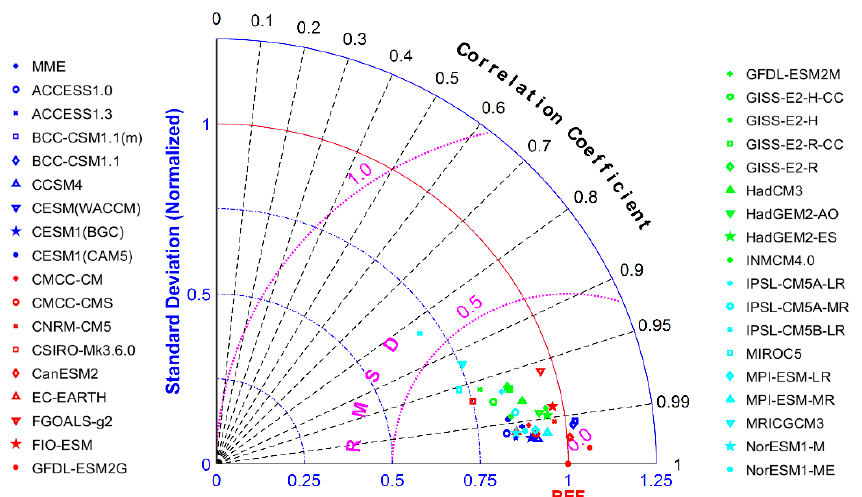
Figure 1. Biases (°C) of the observed and simulated average sea surface temperatures (SSTs), including those produced by the MME (computed by averaging across all models) from 1901 to 2005 during winter (the model name is at the top of each figure, and the subsequent figures are labeled in the same way).